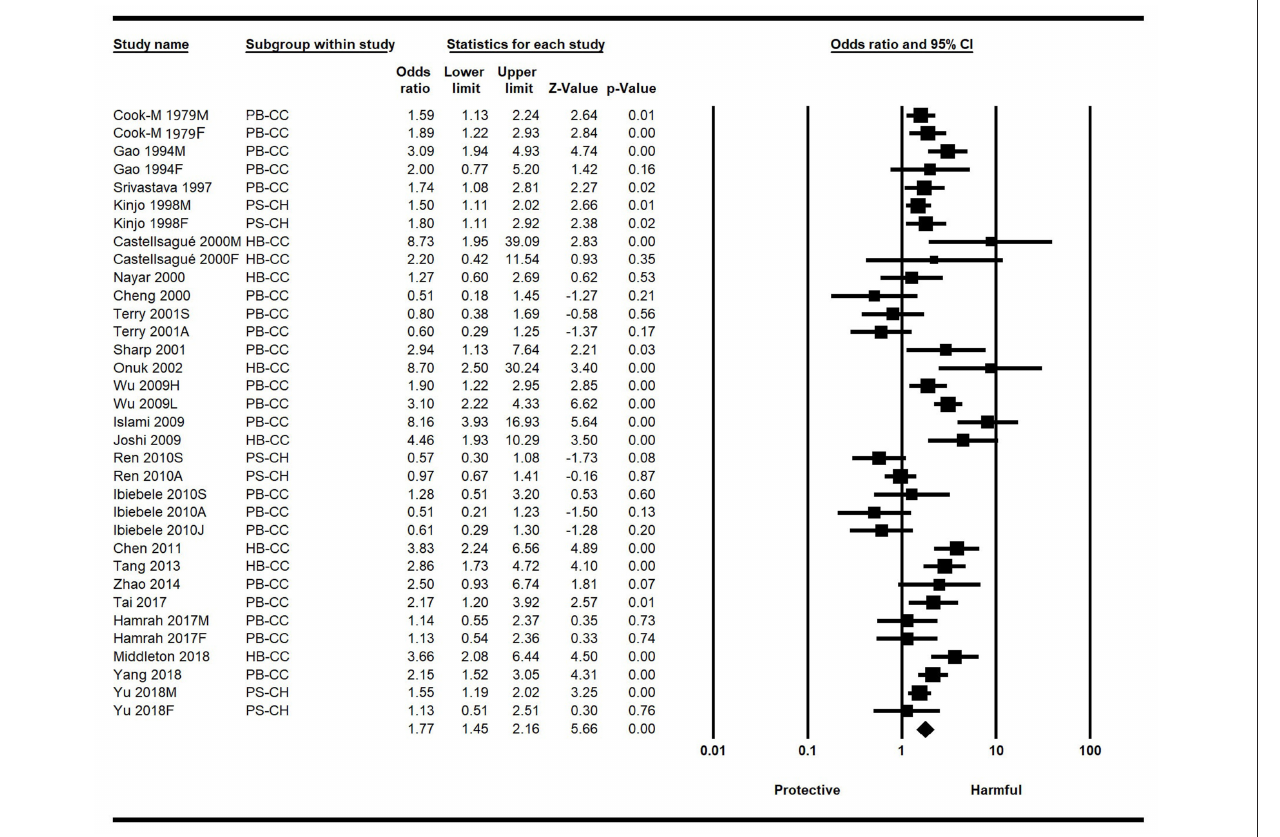
FIGURE 2 | Forest plot of the effect of hot tea drinking on esophageal cancer (EC) risk based on the ORs and 95% CI. CI, confidence intervals; EC, esophageal cancer; HB-CC, hospital-based case control studies; ORs, odds ratios; PB-CC, population-based case control studies; PS-CH, prospective cohort